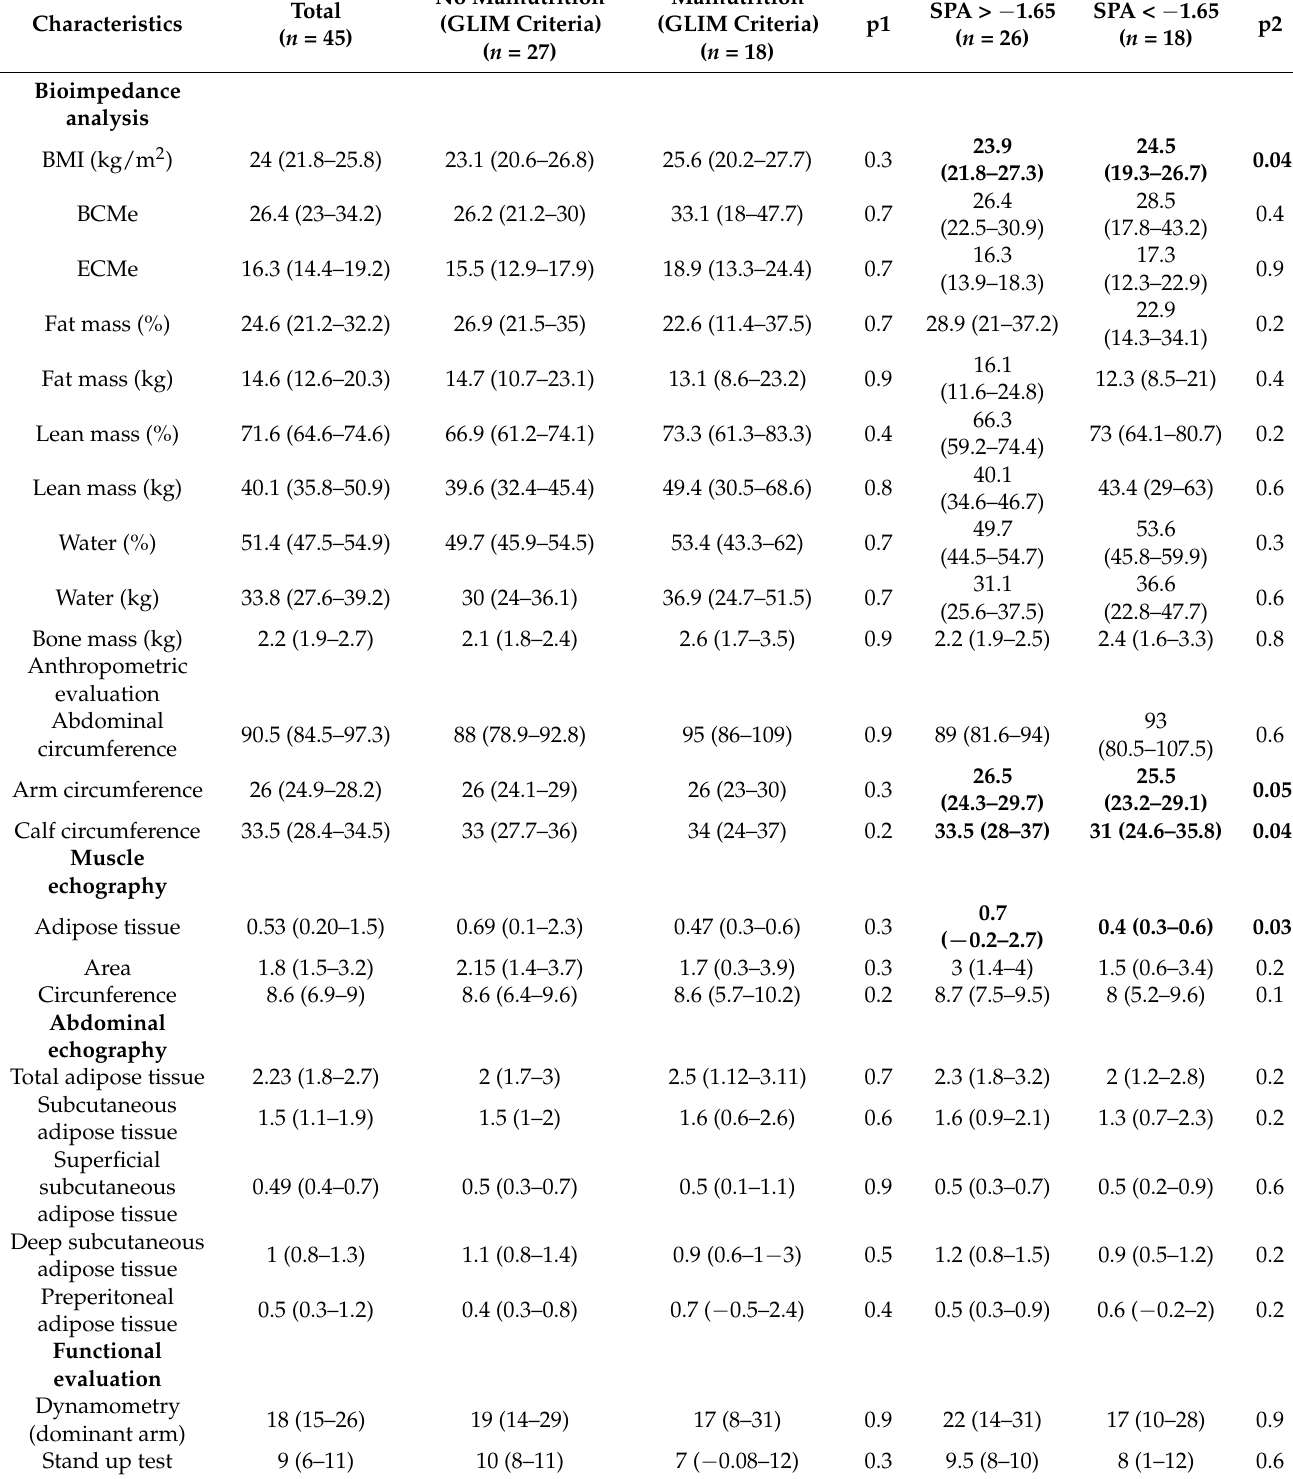
Table 2. Morphofunctional assessment of nutritional status. Comparison between groups based on the presence of malnutrition according to the Global Leadership Initiative on Malnutrition (GLIM) criteria or a standardized phase angle < −